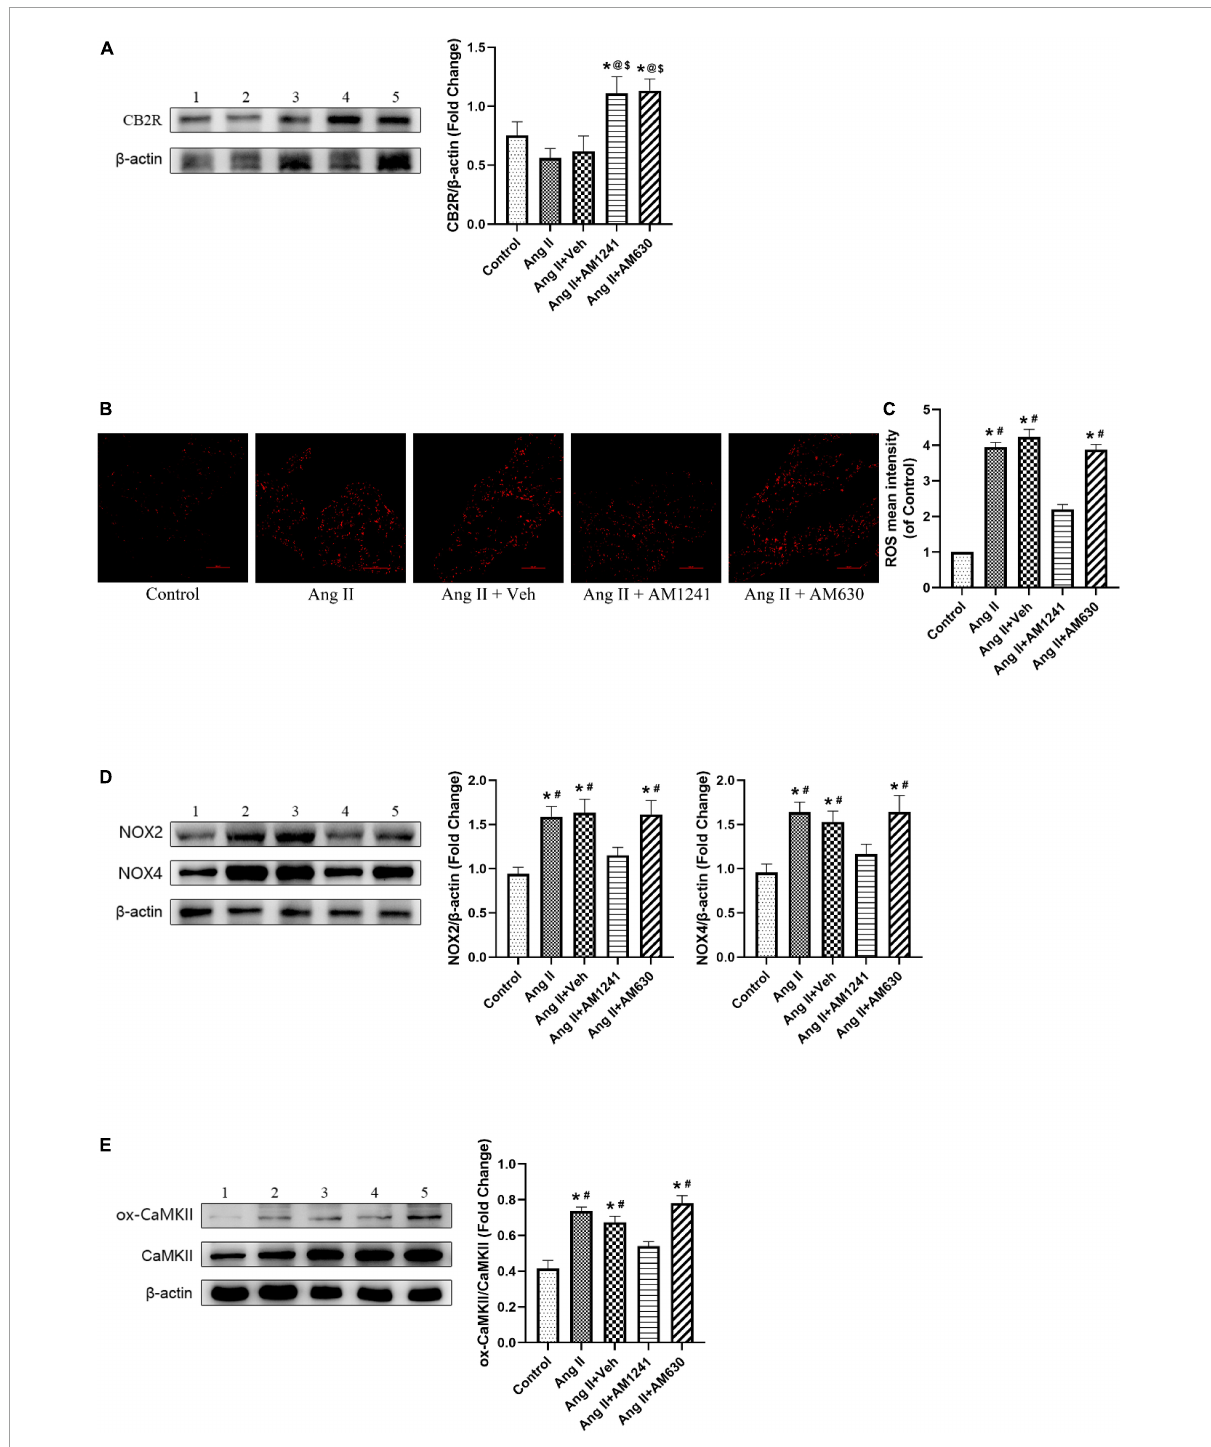
FIGURE3 Administration of AM1241 attenuated oxidative stress in the atrial tissue of Angiotensin II-infused mice by activating cannabinoid receptor 2 (CB2R). (A) Representative western blot image and relative expression of CB2R. (B) Representative picture of reactive oxygen species (ROS) (red) by dihydroethidium staining. Bar = 100 µ m. (C) Quantitative analysis of reactive oxygen species (ROS) mean intensity. (D) Representative western blot image and relative expression of NOX2 and NOX4. (E) Representative western blot image and relative expression of ox-CaMKII and CaMKII. Lane 1: control group; Lane 2: Ang II group; Lane 3: Ang II + Veh group; Lane 4: Ang II + AM1241 group; Lane 5: Ang II + AM630 group. The data represent the mean ± SEM. * P < 0.05 vs. control group. # P < 0.05 vs. Ang II + AM1241 group. @ P < 0.05 vs. Ang II group. $ P < 0.05 vs. Ang II + Veh